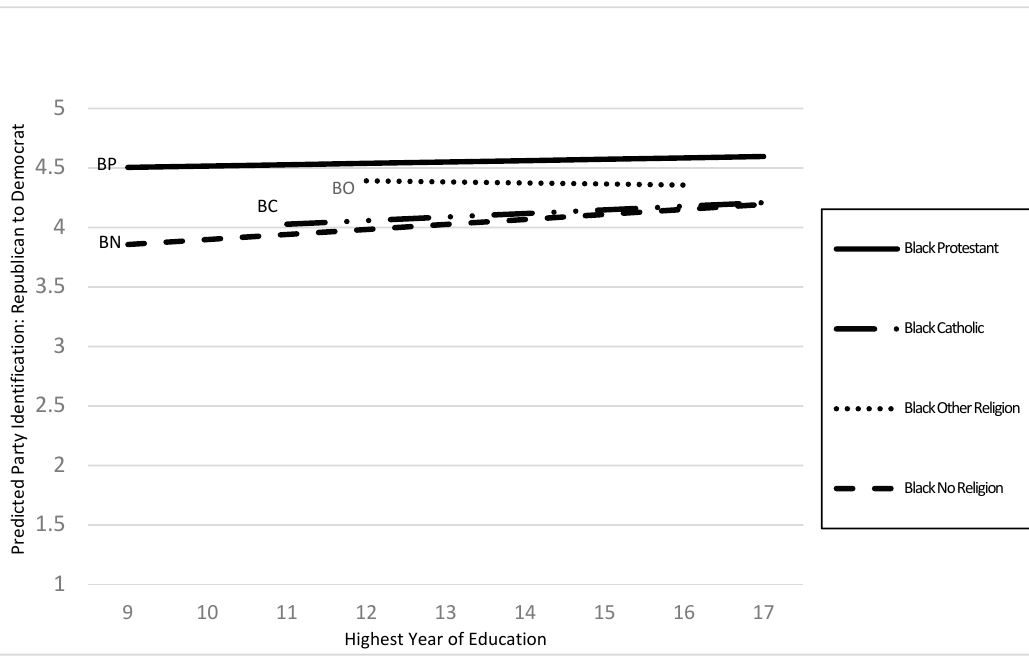
Figure 8. The interaction of religion and education on party identification.